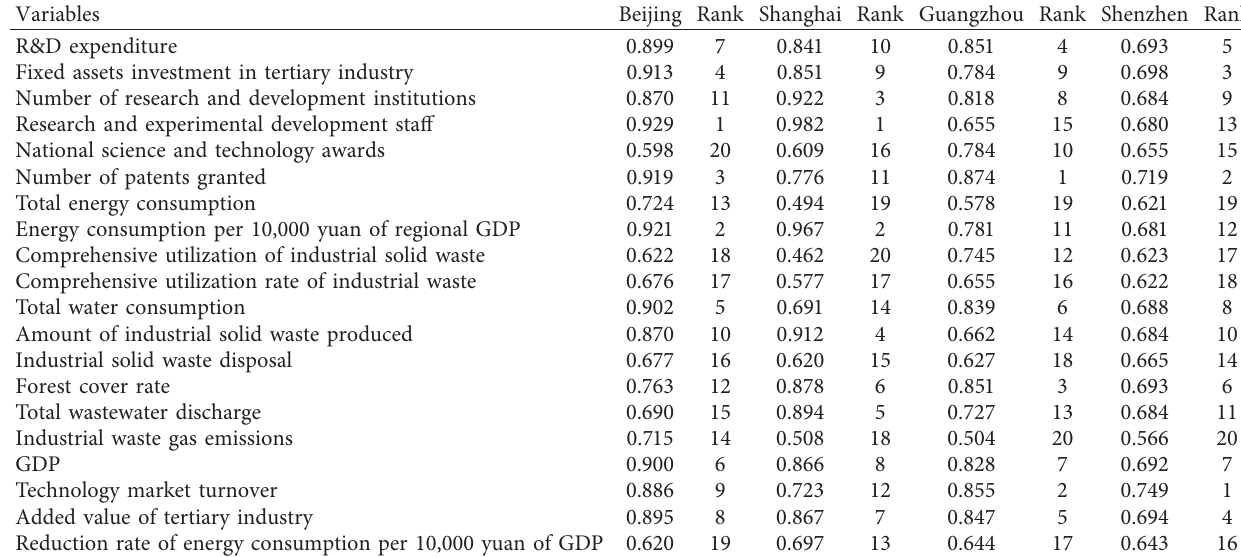
Table 6: 2014–2018 China’s first-tier cities’ green development capacity grey correlation